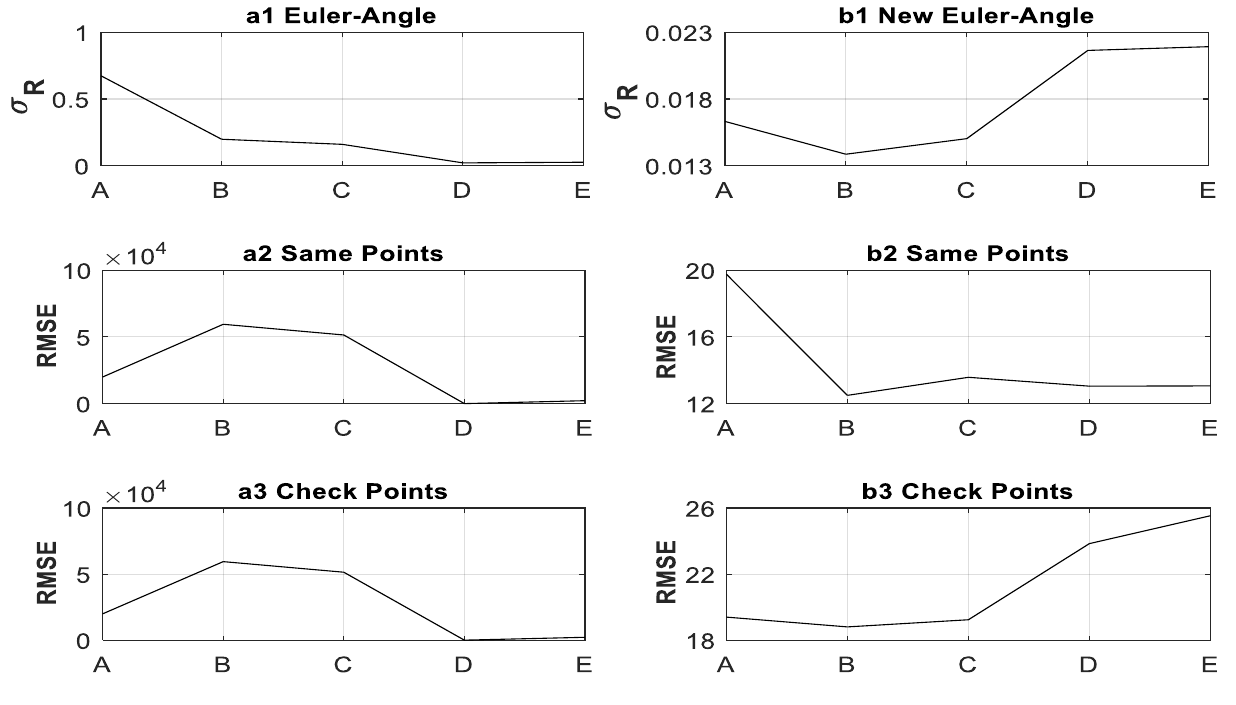
Figure 6. Transformation precision comparison of the R-Method and NR-Method for practical en- gineering application (each x axis value represents a different case selects of the common points, each y axis value represents a different precision for a different precision index ( R  (a.u.), RMSE (mm)) (( a1 – a3 ) shows the results of the R-Method, ( b1 – b3 ) shows the results of the NR-Method).